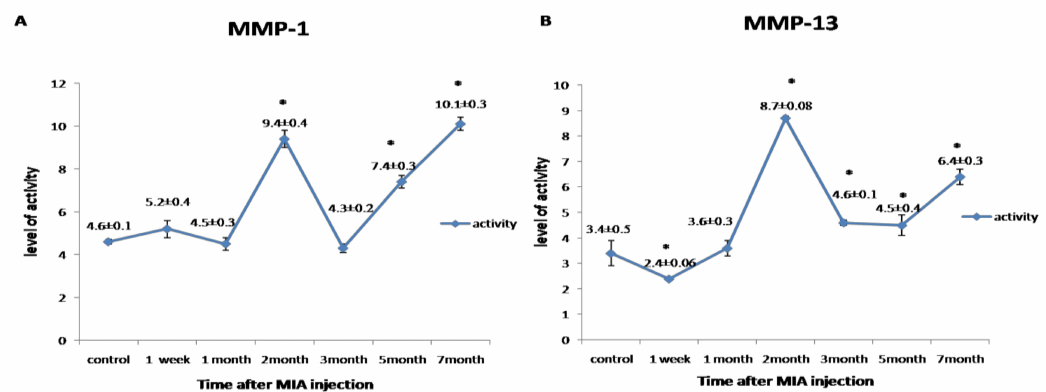
Figure 4. Graphical representation of the changes in the activity of matrix metalloproteinases (MMPs) during the disease progression post-monoiodoacetate (MIA) injection at day 0, 1st week, 1st month, 2nd month, 3rd month, 5th month, and 7th month. ( A ) Representing the activity of MMP-1. ( B ) Representing the activity of MMP-13. All data are represented as (mean ± SEM) for triplicate samples ( n = 3). * denotes a significant di ff erence from control samples at day 0 at p < 0.05. Gelatinase activity for MMP-2 and MMP-9 was detected in a biphasic expression pattern; the first phase started from the first week to the first month, which recorded the highest value of its activity. The second phase started from the third to the seventh month. Meanwhile, the latent MMP-9 first phase of expression started from the first week to the second month, and the second phase began from the fifth month to the end of the experiment. The highest level of gelatinases activity was observed in the first month ( p < 0.05) (Figure